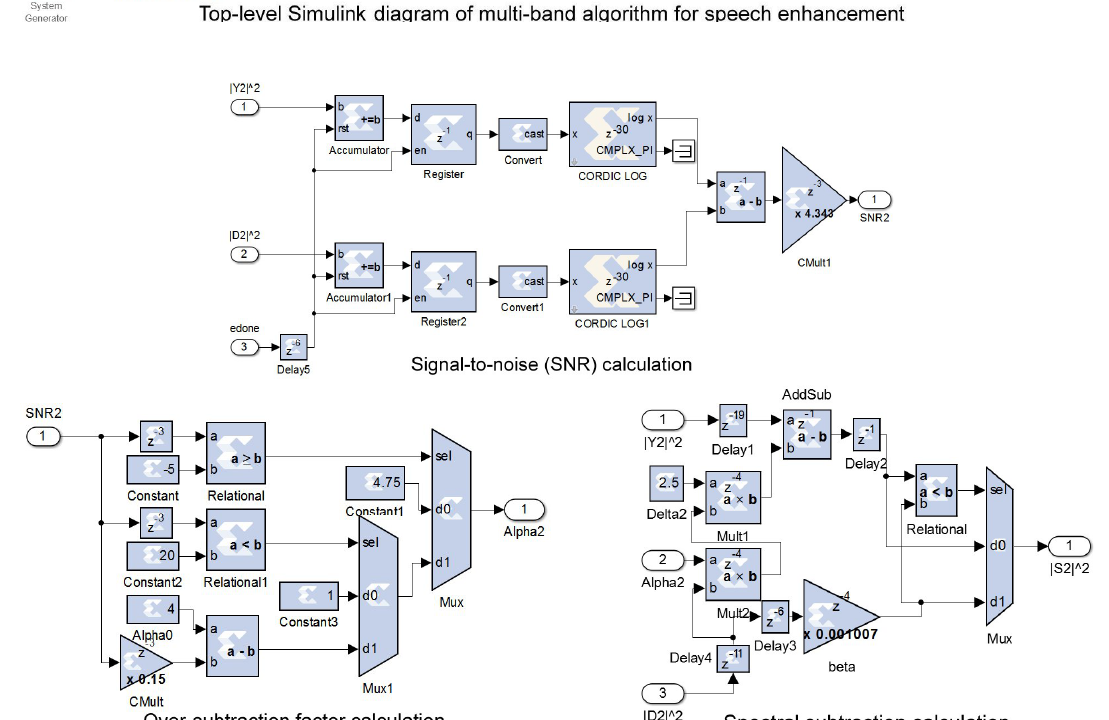
Figure 2. The proposed pipelined architecture of multi-band spectral subtraction using Xilinx system generator (XSG) blockset. The top-level Simulink diagram is shown on the top followed by details of the main calculation subsystems (signal-to-noise ratio, over-subtraction factor, and spectral subtraction). Details about the implementation of noise spectrum estimate can be found in